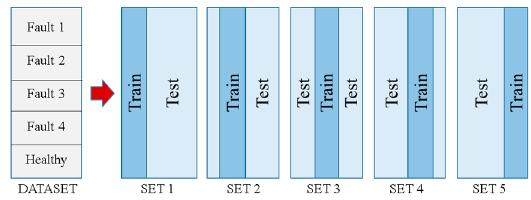
Figure 9. Five sets of cross-validation stratified sampling data partitions.